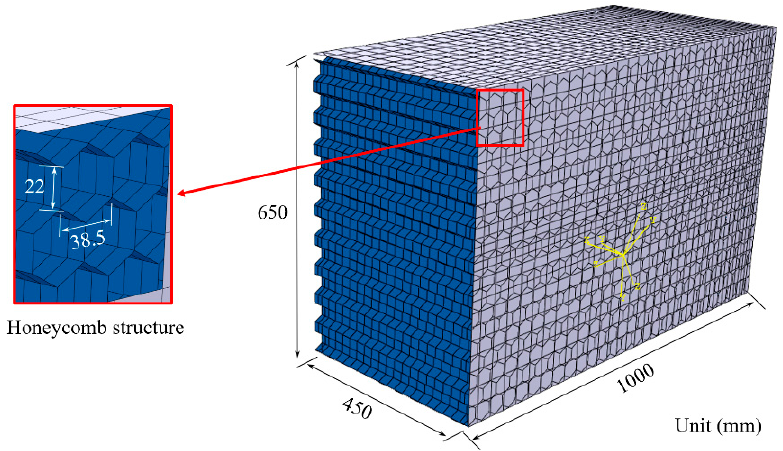
Figure 4. Geometric modeling of an MDB for side crash simulation.